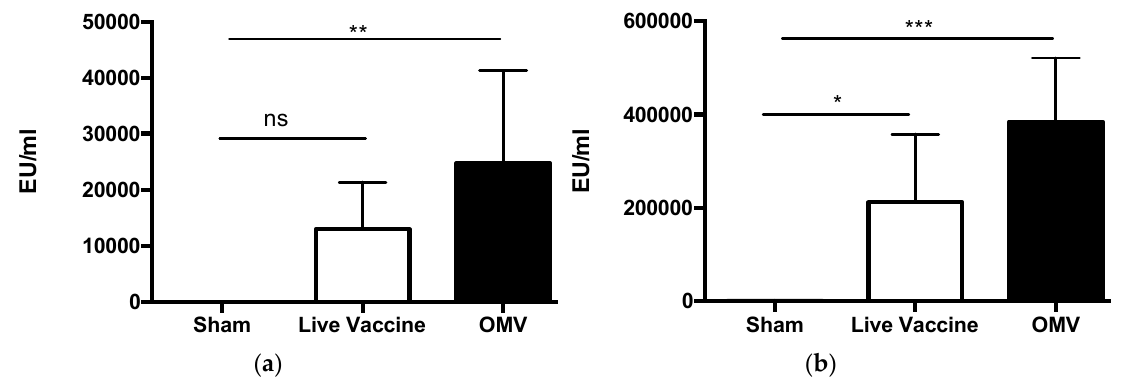
Figure 3. OMV immunization induces B. mallei -specific antibody in mice. ( a ) B. mallei- specific and ( b ) OMV-specific IgG was measured in the sera of mice ( n = 5 per group) immunized with sham, live Bp82, or Bp82 OMVs by ELISA (* p < 0.05 ** p < 0.01 *** p < 0.001 by one way ANOVA, ns = not significant).